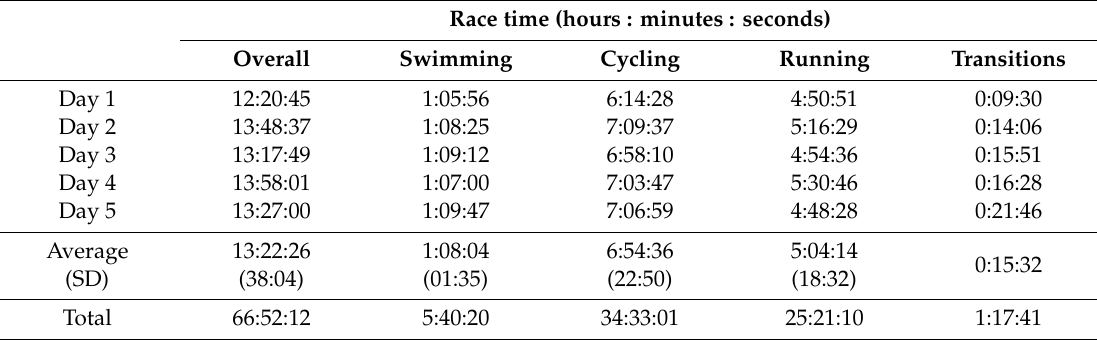
Table 1. Race time in a Quintuple Iron ultra-triathlon.